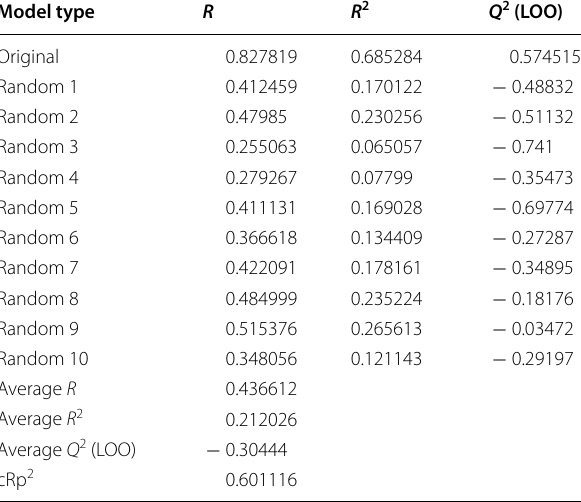
Table 4 Y-randomization assessment of MLR